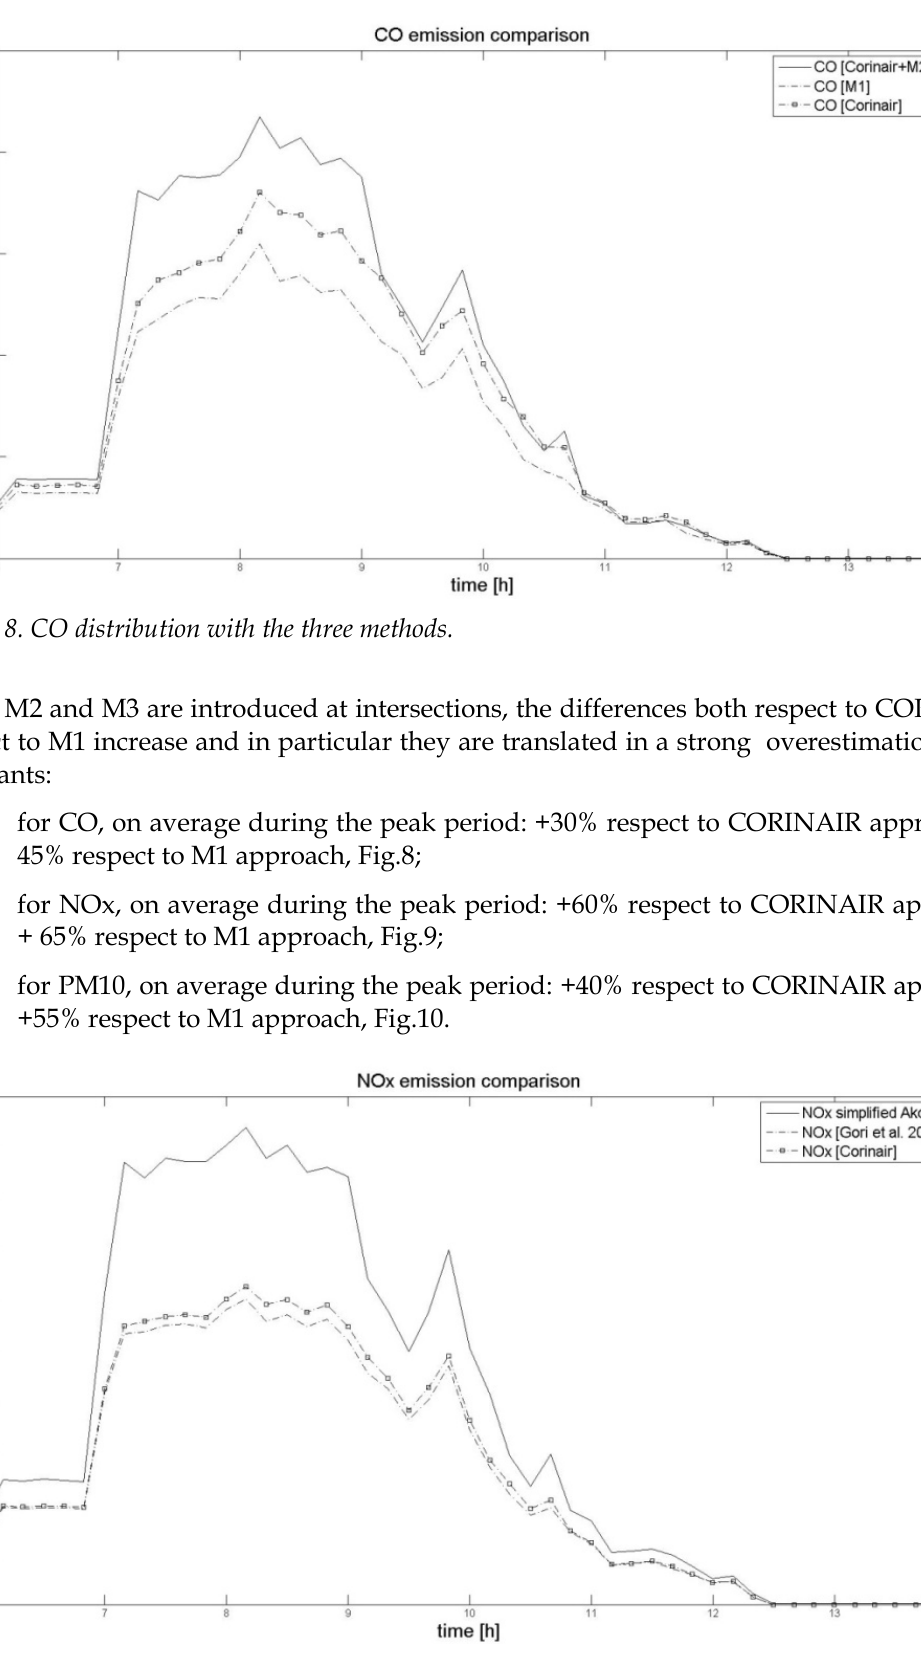
Figure 9. NOx distribution with the three